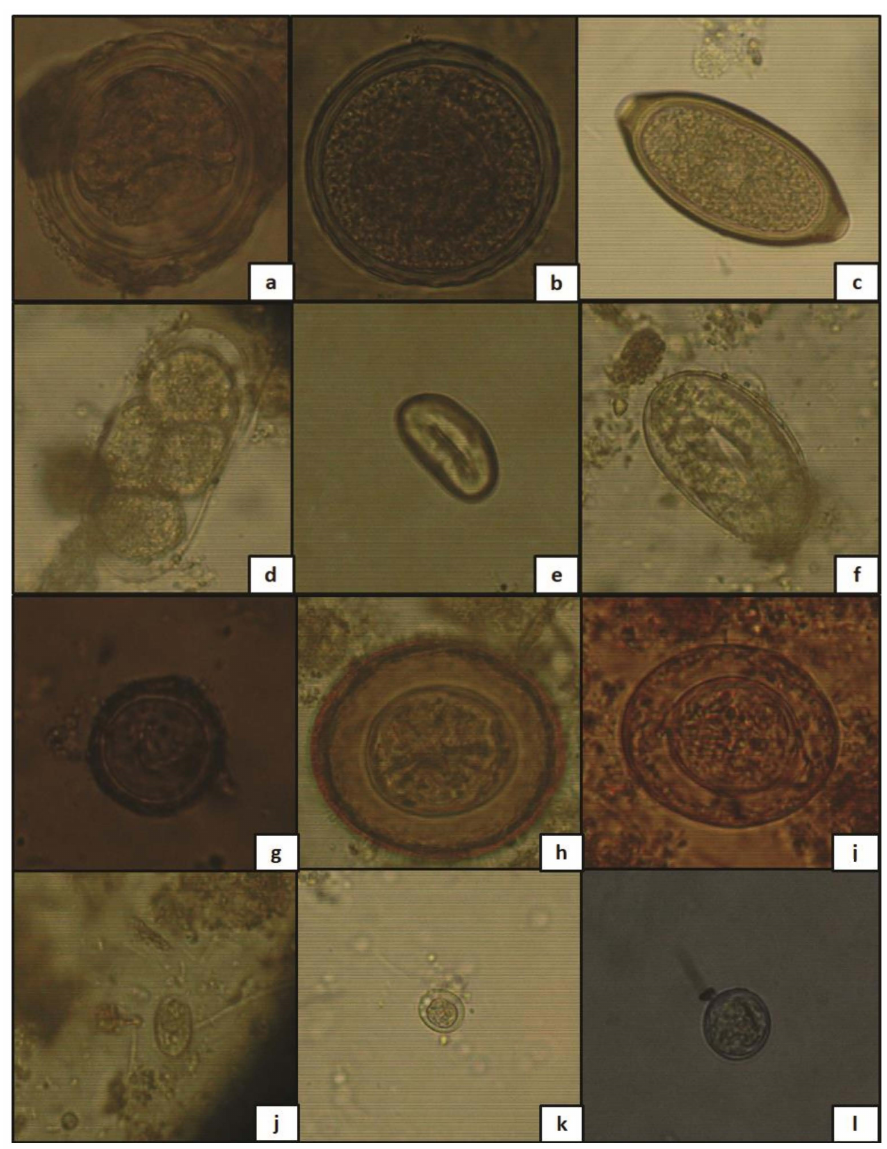
Figure 3. Light microscopic isolated images of common helminth ova found in sludge samples (magnification of 400x): ( a ) Ascaris spp., ( b ) Trichuris spp., ( c ) Toxocara spp., ( d ) Hookworms ( An- cylostoma duodenale and Necator americanus ), ( e ) Enterobius vermicularis , ( f ) Strongyloides stercoralis , ( g ) Taeniid eggs, ( h ) Hymenolepis nana , ( i ) Hymenolepis diminuta ; ( j ) Giardia sp., ( k ) Entameoba histolyt- ica / dispar / moshkovskii , and ( l ) Entamoeba coli